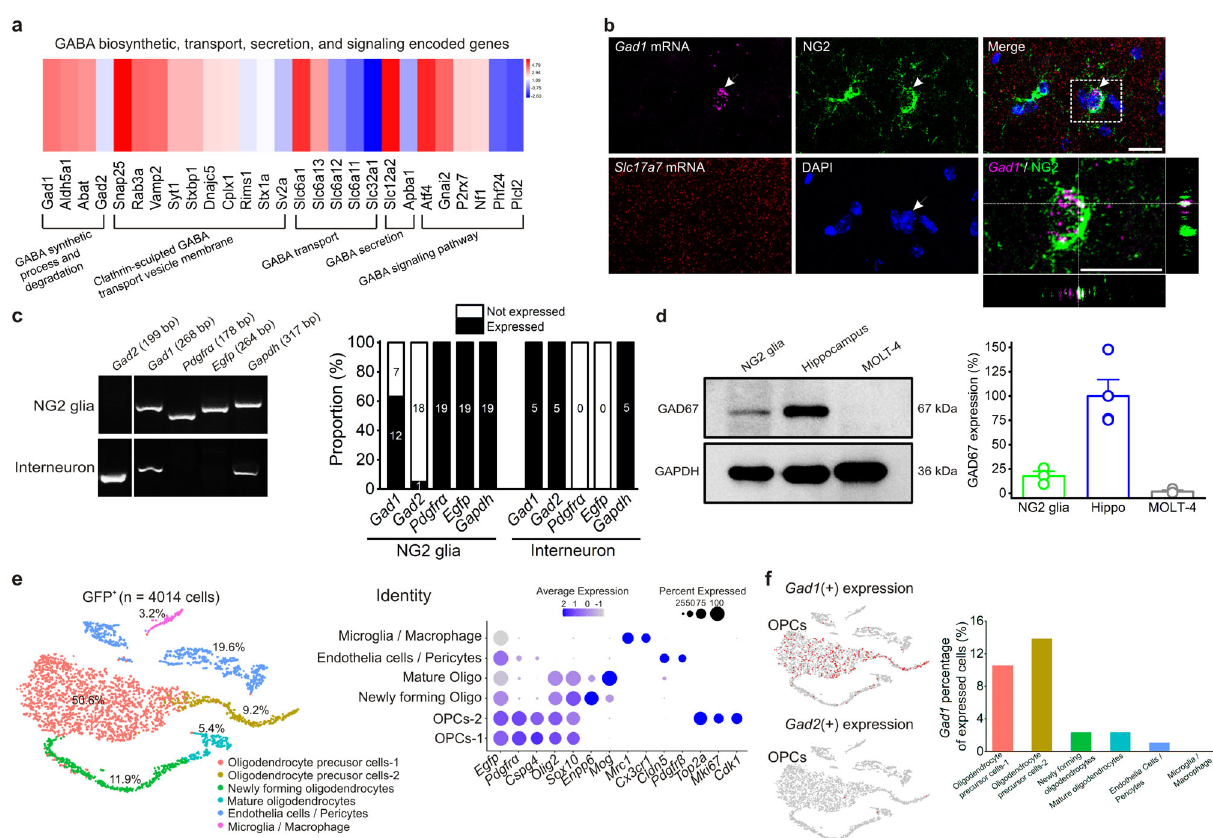
Fig. 4 Transcriptomic analysis of Gad1 expression in NG2 glia. a The gene expression levels with Log2 (FPKM) reveal a transcriptomic pro fi le related to GABA synthetic processes and degradation, clathrin-sculpted GABA transport vesicle membrane, GABA transport, secretion, and GABA signaling pathway. Note that Gad1 gene (GAD67) is relatively highly expressed in NG2 glia isolated from 3 Pdgfr α -creER TM ;mGFP mice brains at postnatal 3 – 4 weeks. b Representative images of RNAscope with post-immunohistochemistry reveal a colocalization of Gad1 mRNA but not Slc17a7 mRNA with an individual GFP-labeled NG2 glial cell. The colocalization image in the white dotted box is magni fi ed as indicated with arrows. The image data are repeated from 3 mice at postnatal 4 – 6 weeks. Scale bars, 20 μ m. c Representative images and bar graph summary showing single-cell RT-PCR analysis of Gad1 and Gad2 mRNA expression in NG2 glia with interneuron as its control from hippocampal CA1 region of Pdgfr α -creER TM ;mGFP mice at postnatal 3 – 4 weeks. Note 12 out of 19 GFP ( + ) cells showed distinct Gad1 but not Gad2 expression in NG2 glia. d Representative images of western blot and bar graph summary showing GAD67 protein expression in the puri fi ed NG2 glia by FACS from 3 Pdgfr α -creER TM ;mGFP mice brain at postnatal 3 – 4 weeks. GAD67 expression in NG2 glia is 17.81 ± 4.76% ( n = 3) relative to hippocampal tissue ( n = 4). MOLT-4 cells as a negative control ( n = 3). e Single-cell RNA-sequencing analysis shows a t-distributed stochastic neighbor embedding (t-SNE) plot depicting the cell-type identity of total 4014 EGFP ( + ) cells by FACS from a Pdgfr α -creER TM ;mGFP mouse hippocampus at postnatal 3 weeks. Six clusters identi fi ed on the basis of the expression of well-established marker genes are shown in the right graph. f t-SNE maps visualizing single-cell gene expression of Gad1 and Gad2 within six clusters. Note that Gad1 but not Gad2 mainly distributes in the OPC subclusters 1 and 2. Bar graph summarizes the percentage of Gad1 expression within each cluster cells. Data are presented as mean values ± SEM and error bar represents